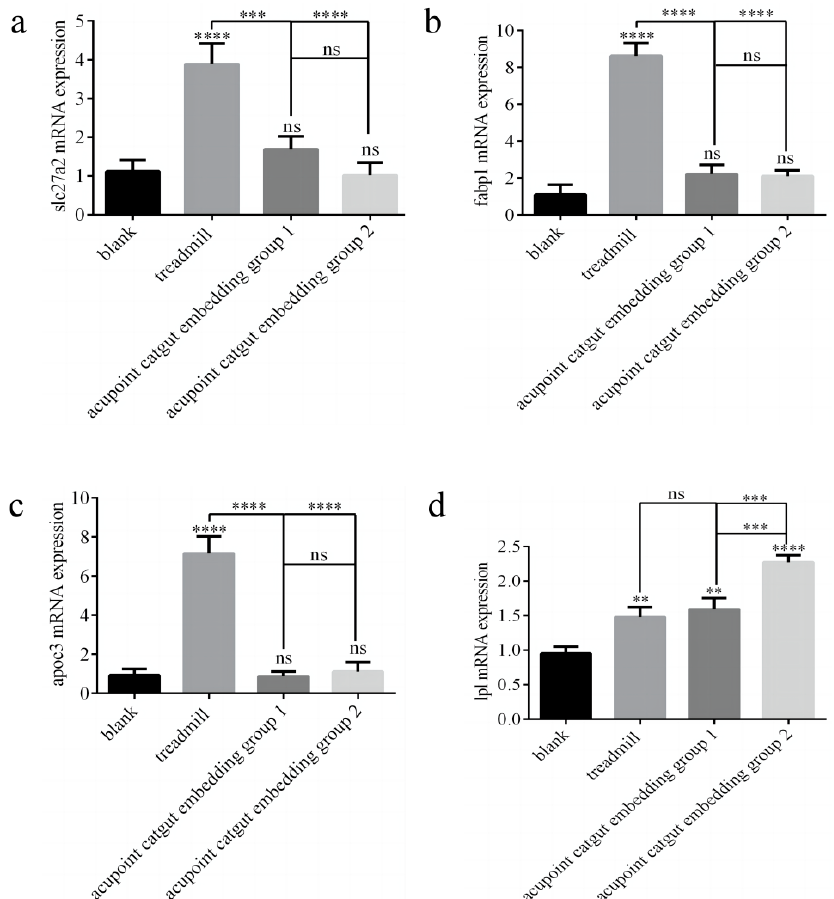
Figure 9. Slc27a2 , Fabp1 , Apoc3 , and Lpl gene mRNA and protein expression in the quadriceps femoris related to the PPAR signaling pathway. ( a ) Slc27a2 mRNA, ( b ) Fabp1 mRNA, ( c ) Apoc3 mRNA, and ( d ) Lpl mRNA. ** p < 0.01, *** p < 0.001, **** p < 0.0001; ns: not significant ( p >0.05). Slc27a2 : solute carrier family 27 member 2; Fabp1 : fatty acid binding protein 1; Apoc3 : apolipoprotein C3; Lpl : lipoprotein lipase.